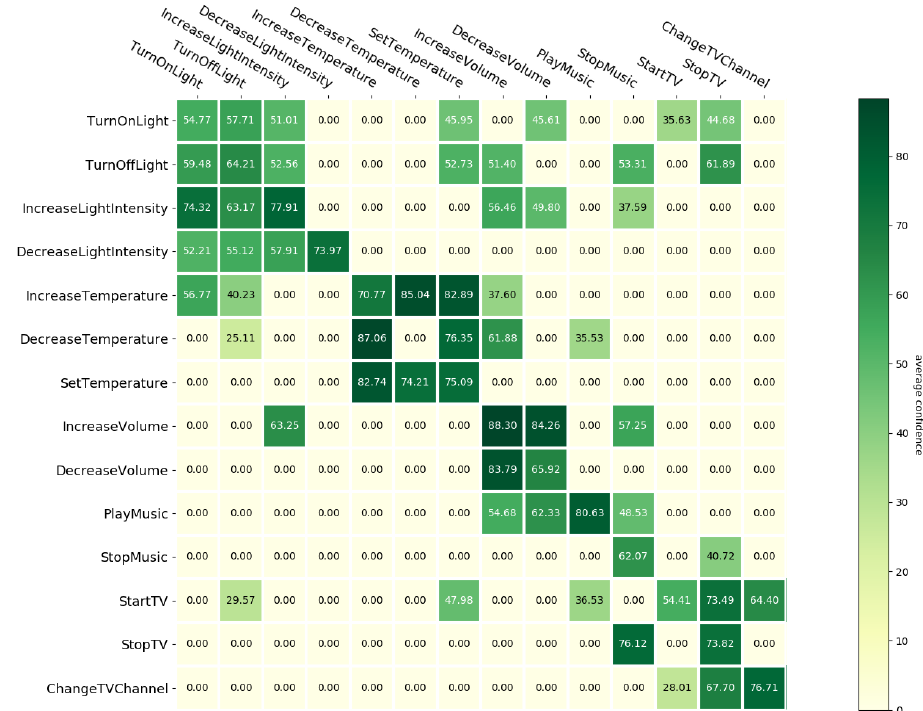
Figure A3. Confidence matrix for Scenario 3.1.